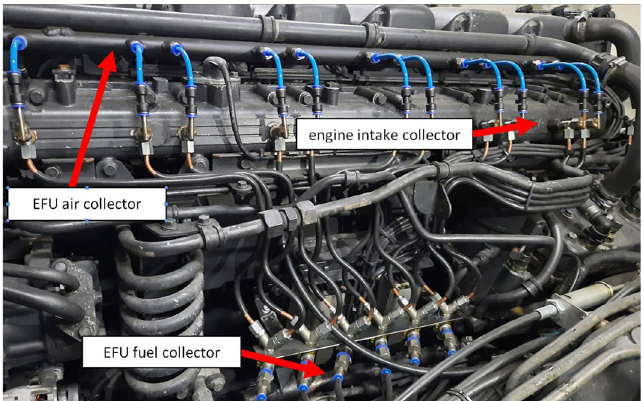
Figure 6. The DC11 engine with the EFU in the experimental truck. (Source: Authors).